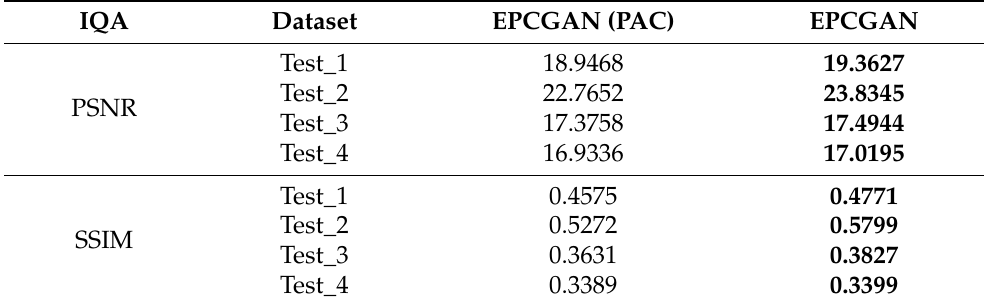
Table 5. Image quality assessment (IQA) results of EPCGAN(PAC) and EPCGAN. The best values for each quality index are shown in